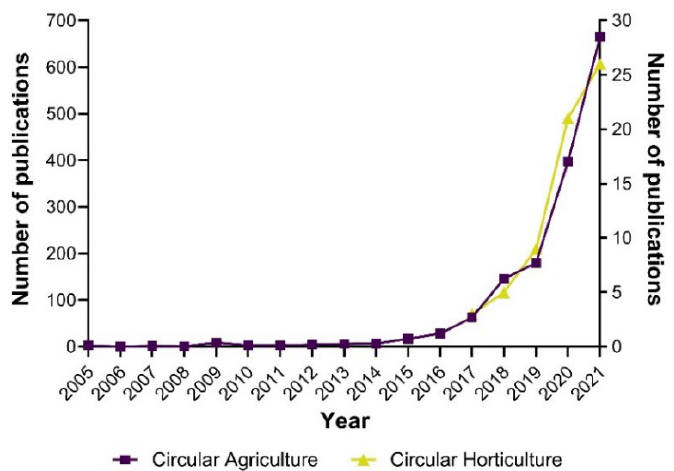
Figure 2. Annual publication trend on circular agriculture and circular horticulture from Scopus database. The number of publications per year is the sum of original articles and reviews. The left Y axis of the figure corresponds to circular agriculture, while the right Y axis corresponds to circular horticulture—own